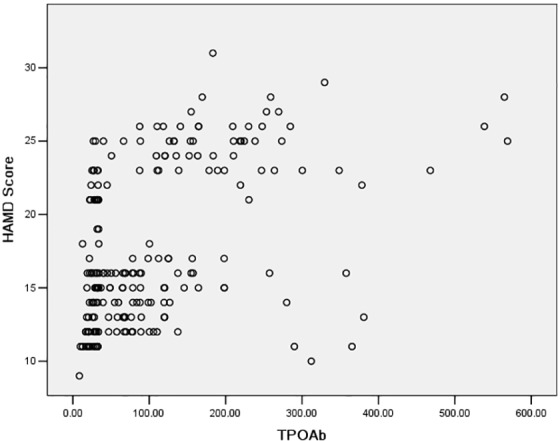
Scatter plot of correlation between HAMD score and TPOAb.